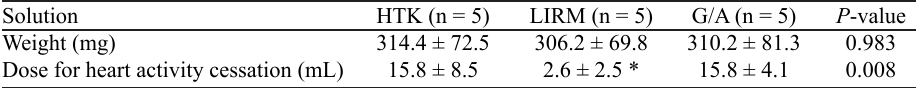
Table 2. Animal weights and cardioplegic solution volumes required for total cessation of heart activity Solution Weight